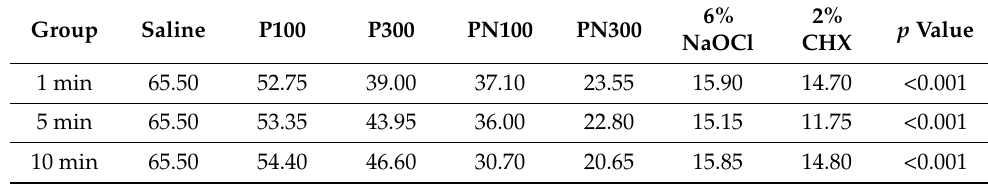
Table 2. Comparison of mean rank in between groups at 1, 5, and 10 min, 400 µ m (Kruskal–Wallis).